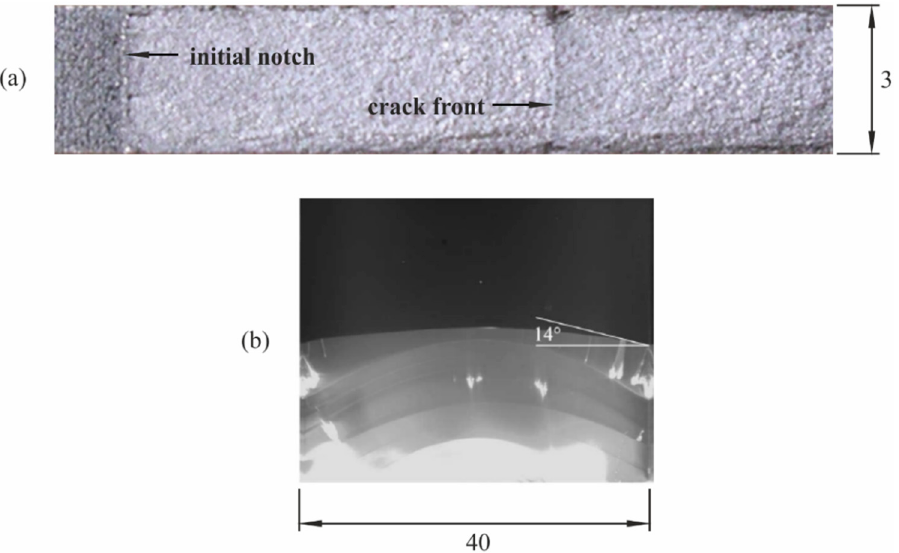
Figure 6. The crack front shapes observed in the experiments for the: ( a ) 6082-T6 aluminium alloy reprinted with permission from ref. [11], copyright 2021 Elsevier and ( b ) polymethyl methacrylate reprinted with permission from ref. [26], copyright 2021 Elsevier. Propagation direction is from left to right in case ( a ) and from bottom to top in case ( b ). All dimensions are in millimetres.